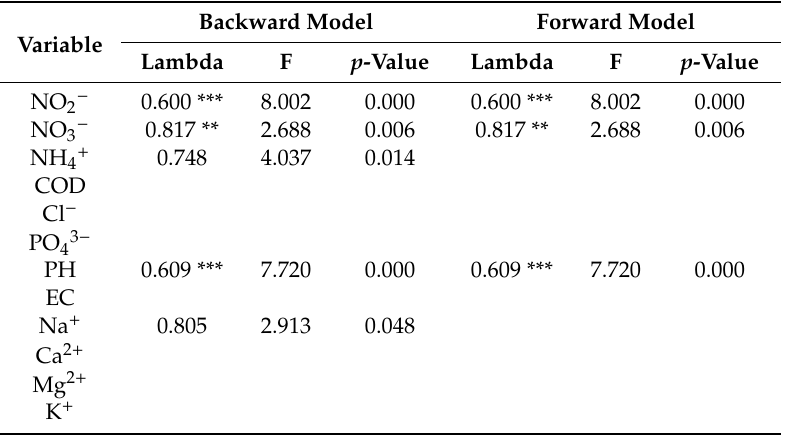
Table 5. Unidimensional lambda test of the quality of water parameter equality in the wet season. Backward Model Forward Model Variable Lambda F p -Value Lambda F p -Value NO 2 − 0.729